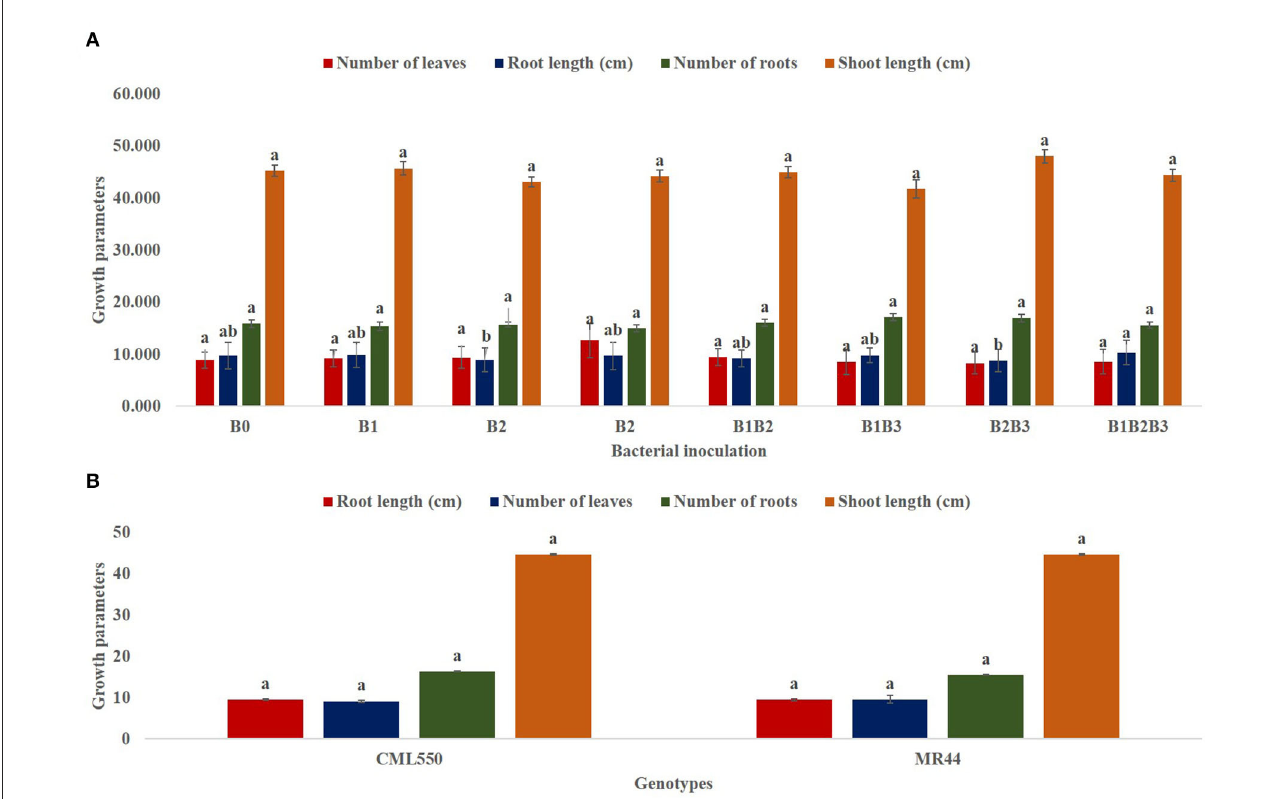
FIGURE4 (A) Effect of bacterial inoculation on growth parameters of maize genotypes; (B) Effect of genotype on growth parameters. Values are presented as means ± standard error [ (A) n = 24, (B) n = 96]. Means with different letters are significantly different from each other [Tukey’s Studentized Range (HSD) test ( p ≤ 0.05)]. B 0 , un-inoculated control; B 1 , Pseudomonas sp. MRBP4; B 2 , Pseudomonas sp. MRBP13; B 3 , Bacillus sp. MRBP10; B 1 B 2 , Pseudomonas sp. MRBP4 + Pseudomonas sp. MRBP13; B 1 B 3 , Pseudomonas sp. MRBP4 + Bacillus sp. MRBP10; B 2 B 3 , Bacillus sp. MRBP10 + Pseudomonas sp. MRBP13;